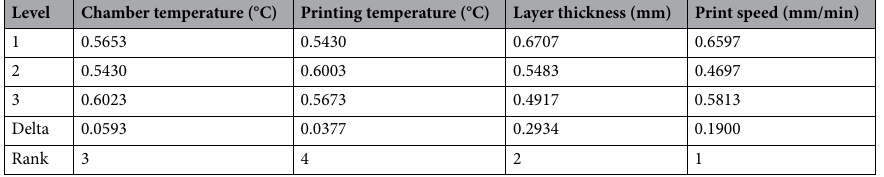
Table 8. Response table for signal to noise ratios of GRG.